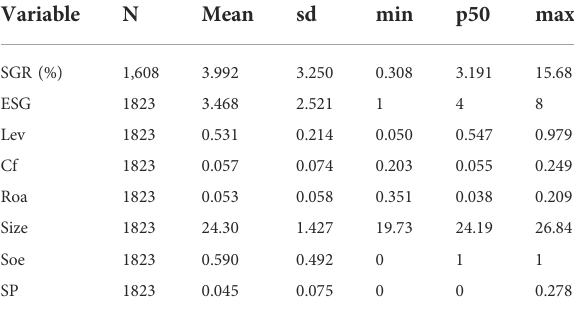
TABLE 2 Statistics of the regression variables. Variable